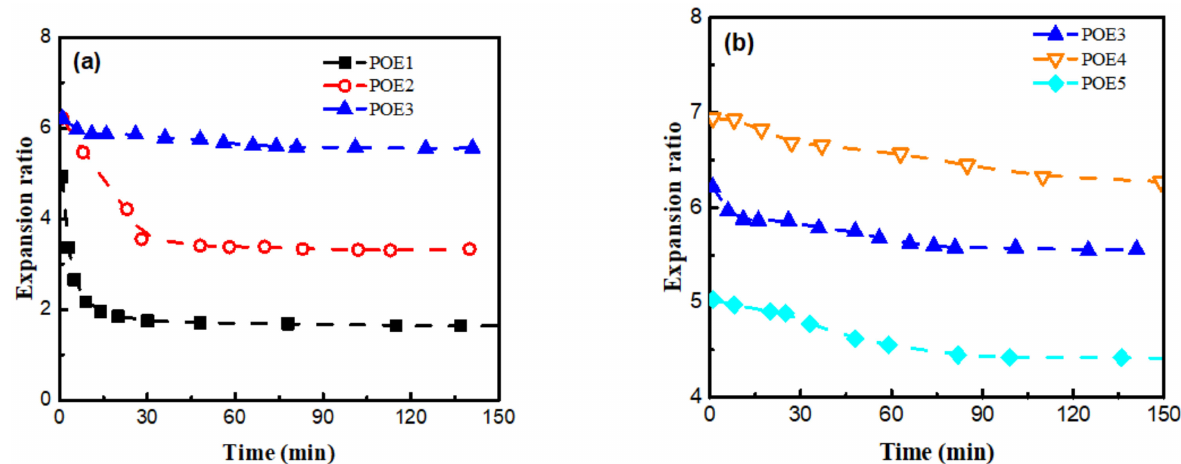
Figure 14. Shrinkage behavior of POE foams with lower expansion ratio. ( a ) POE samples with same MI; ( b ) POE samples with same octene content.